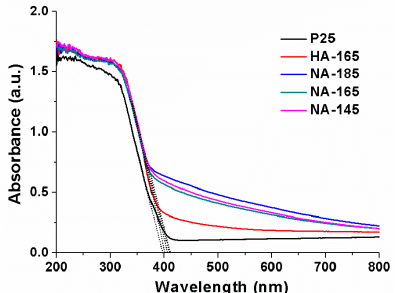
Figure 4. The UV ‐ vis diffuse reflectance spectra of NA ‐ 145, NA ‐ 165, NA ‐ 185, HA ‐ 165, and P25. Figure 4. The UV-vis diffuse reflectance spectra of NA-145, NA-165, NA-185, HA-165, and P25.